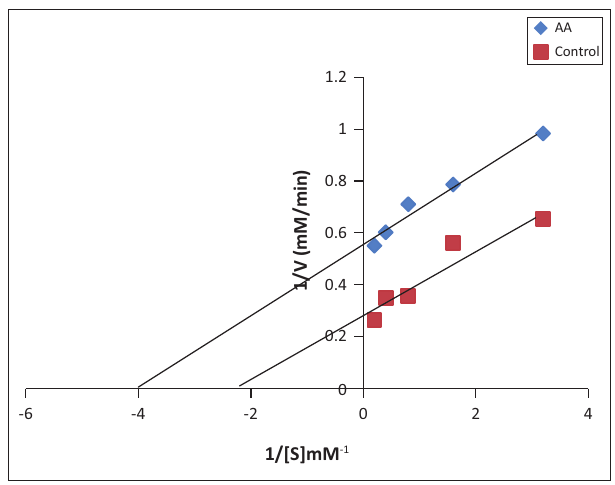
FIGURE 8: Lineweaver-Burk plot of acetone extract of leaves of Acalypha godseffiana eliciting uncompetitive inhibition on α-glucosidase activity. Results = mean ± SEM ( n = 3); ( p < 0.05). AA, A. godseffiana acetone leaf extracts. TABLE 4: IC